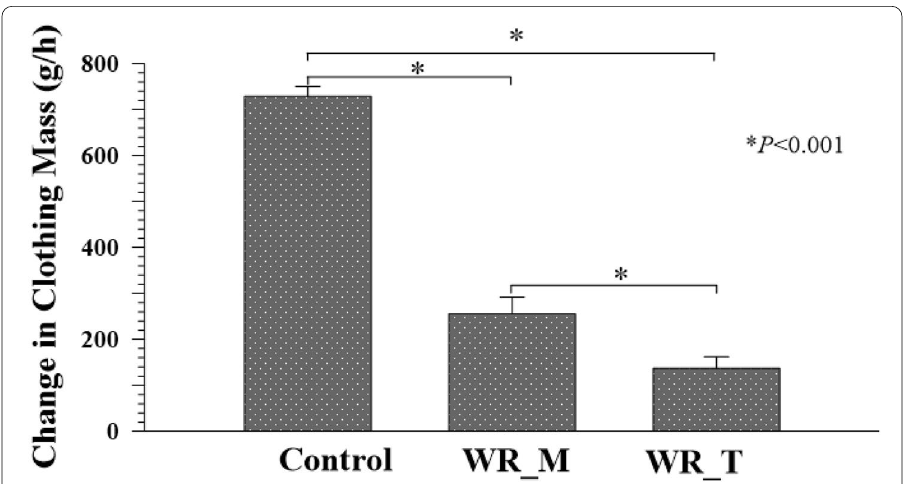
Fig. 5 Changes in clothing weight after the rainfall test. A 60‑min trial consisted of 10‑min rest followed by 30‑min rainfall and 20 min recovery